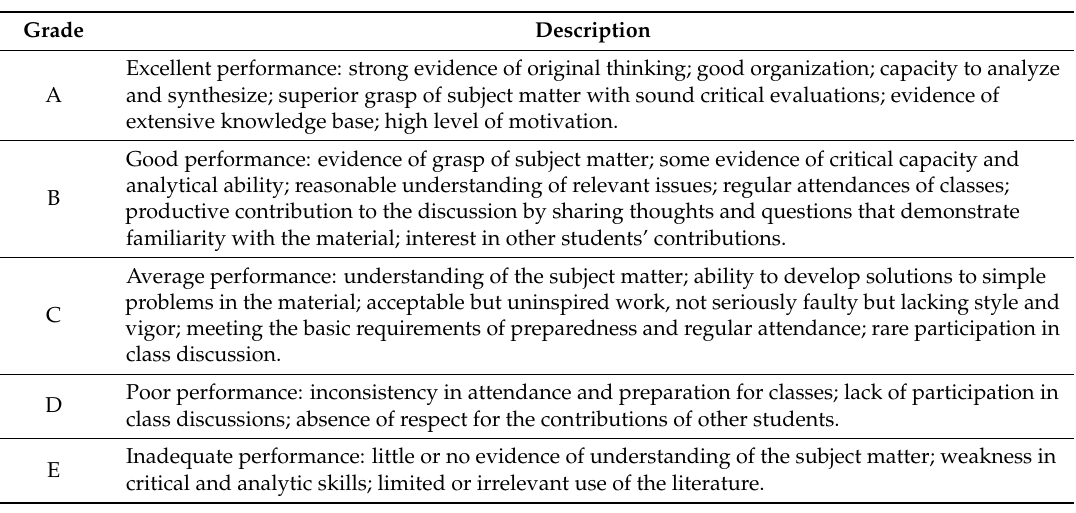
Table 1. An example of detailed grading guidance: grading system of the Academy of the Organization for Security and Cooperation in Europe